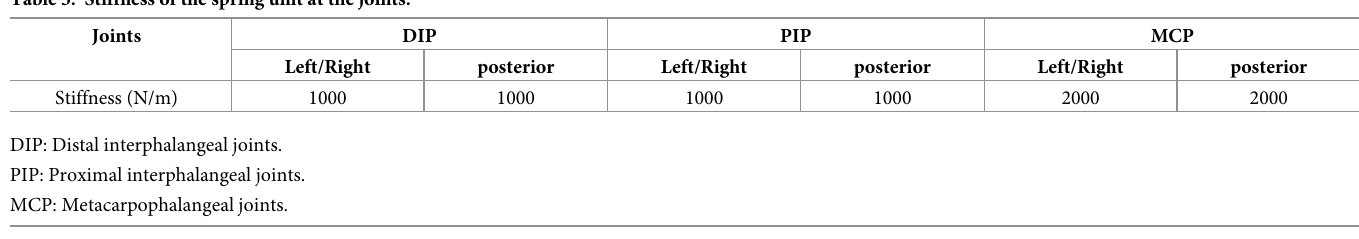
rotation of the joint and the line of action of the muscle-tendon force [29]. One popular tech- nique for estimating MA values is the tendon excursion method, which calculates the instanta- neous MA based on the slope of tendon displacement versus joint angle [30,31]. In the present study of the flexion without resistance, the MCP, PIP, and DIP joints were angularly displaced by the combined muscle forces of FDS, FDP, and ED. In the current model’s loading condi- tions, the displacement loads were loaded uniformly. Initially, the MCP joint rotated at the largest angular velocity of the three joints due to the combined forces of the FDS and FDP. This was followed by the PIP joint rotating rapidly due to the rapidly increasing MA of the FDS and FDP on it. Finally, the DIP joint rotated rapidly due to the rapidly increasing MA of FDP on it. The difference in angular velocity of the three joints caused the FDS and FDP in turn to produce a structural MTJ displacement due to the change in the spatial position of the finger. With this displacement, the length of the tendon was constant and therefore the calcu- lated muscle force did not increase. This resulted in a significant plateau in muscle force over time for both FDS and FDP in the flexion without resistance (Fig 10).